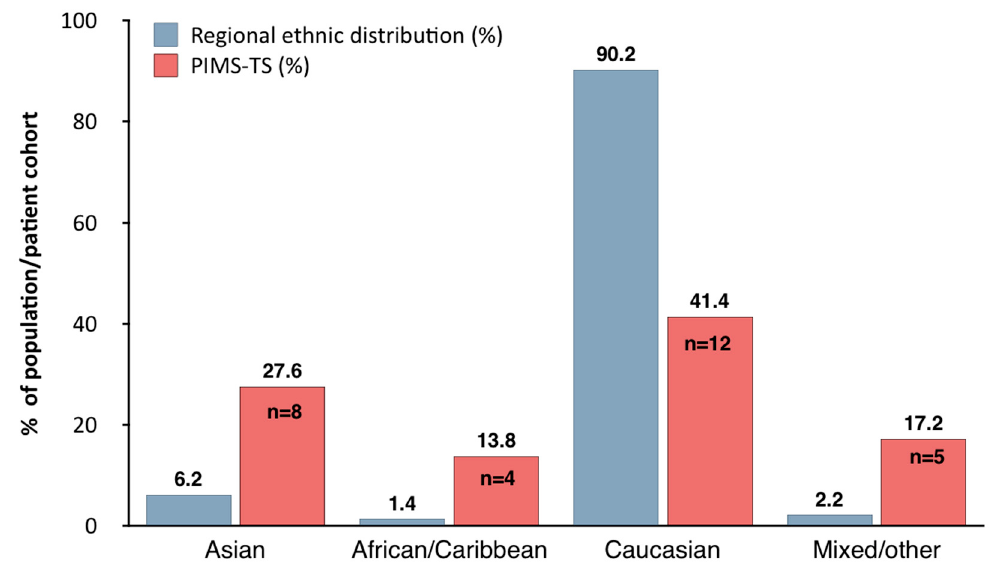
Figure 2. Distribution of ethnicities among children presenting with paediatric multisystem inflammatory syndrome temporally associated with SARS-CoV-2 in relation to regional ethnic distribution in the North West of England, as per National Census Data (https: // www.ethnicity-facts-figures.service.gov.uk / uk-population-by-ethnicity / national-and- regional-populations / regional-ethnic-diversity /